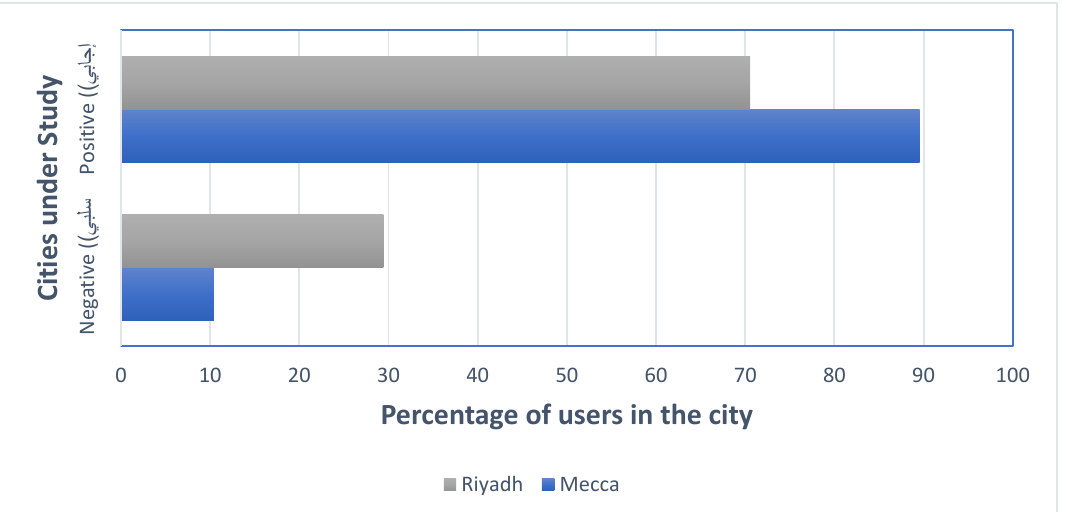
Figure 2. Proportion of positive and negative feelings expressed by people residing in Mecca and Riyadh.